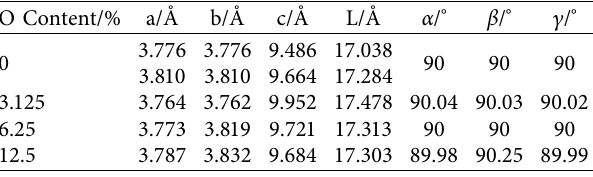
Figure 6: Normalized oxygen defect formation energy E TiO 2 system as a function of content. Table 3: Lattice constants for intrinsic anatase TiO defected anatase TiO 2 .